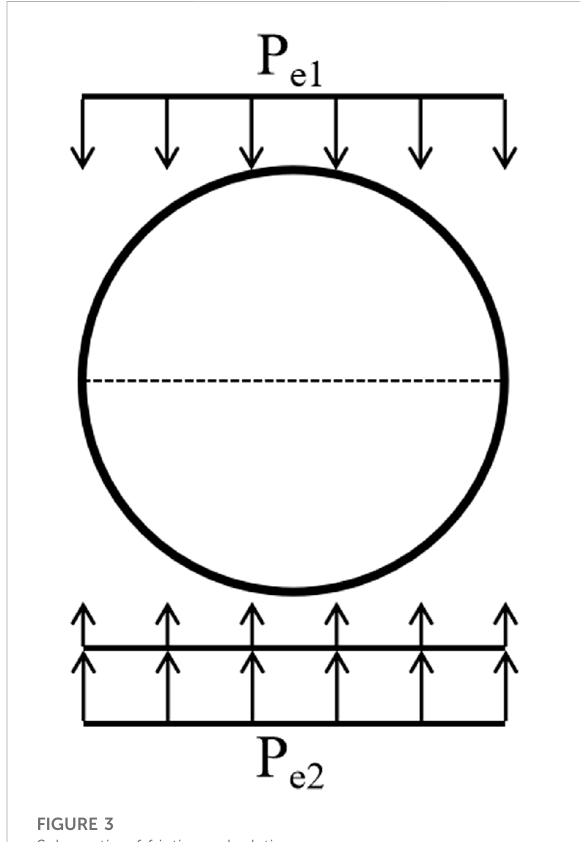
FIGURE 3 Schematic of friction